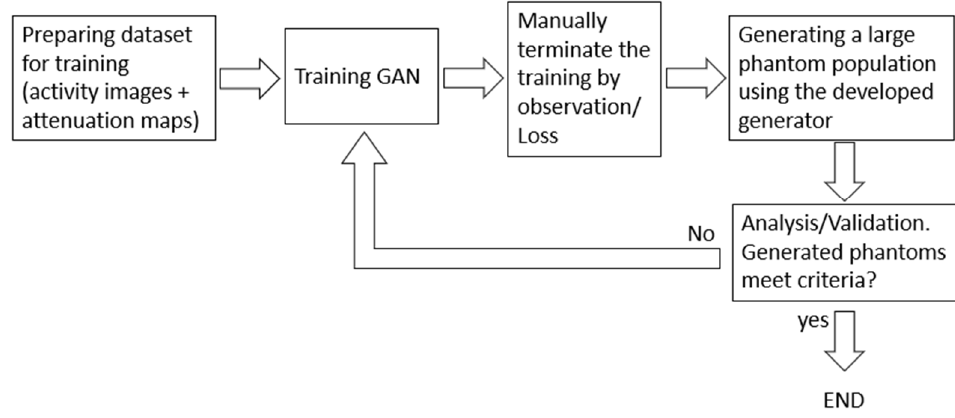
Figure 8. Flow chart—training a GAN for generating brain phantoms for SPECT research.